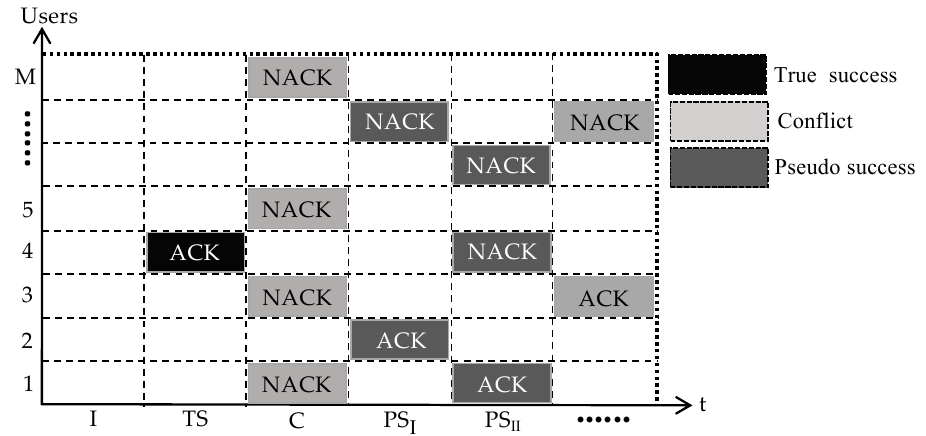
Figure 3. Feedback response of the receiver in four cases.